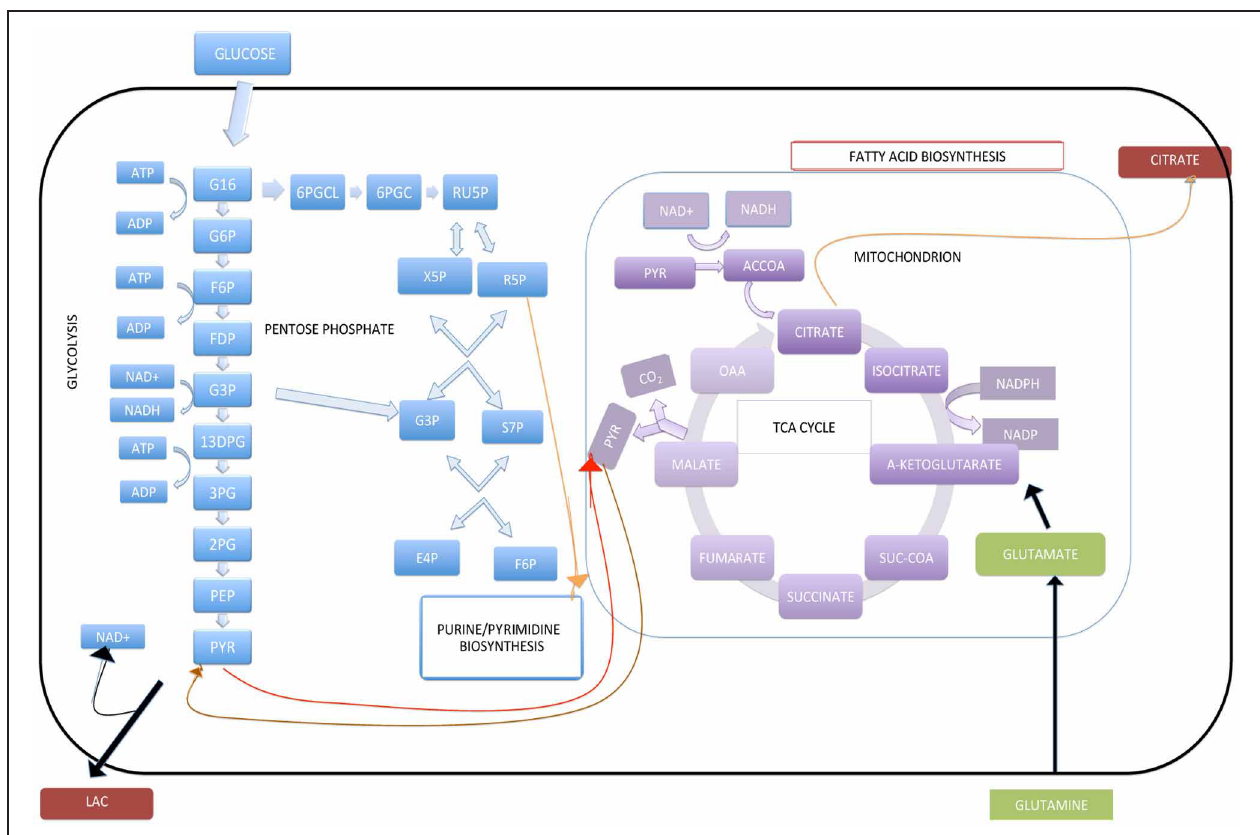
FIGURE 2 | Central metabolism in cancer cell lines. LAC represents lactate, G6P represents glucose-6phosphate, F6P represents fructose 6 phosphate, FDP represents fructose 1,6 biphospate, G3P represents glyceraldehydes 3 phosphate, 13DPG represents 1,3 biphosoglycerate, 3PG represent 3 phosphoglycerate, 2PG represents 2-phopho glycerate, PEP represents phosphenol pyruvate, PYR represents pyruvate,